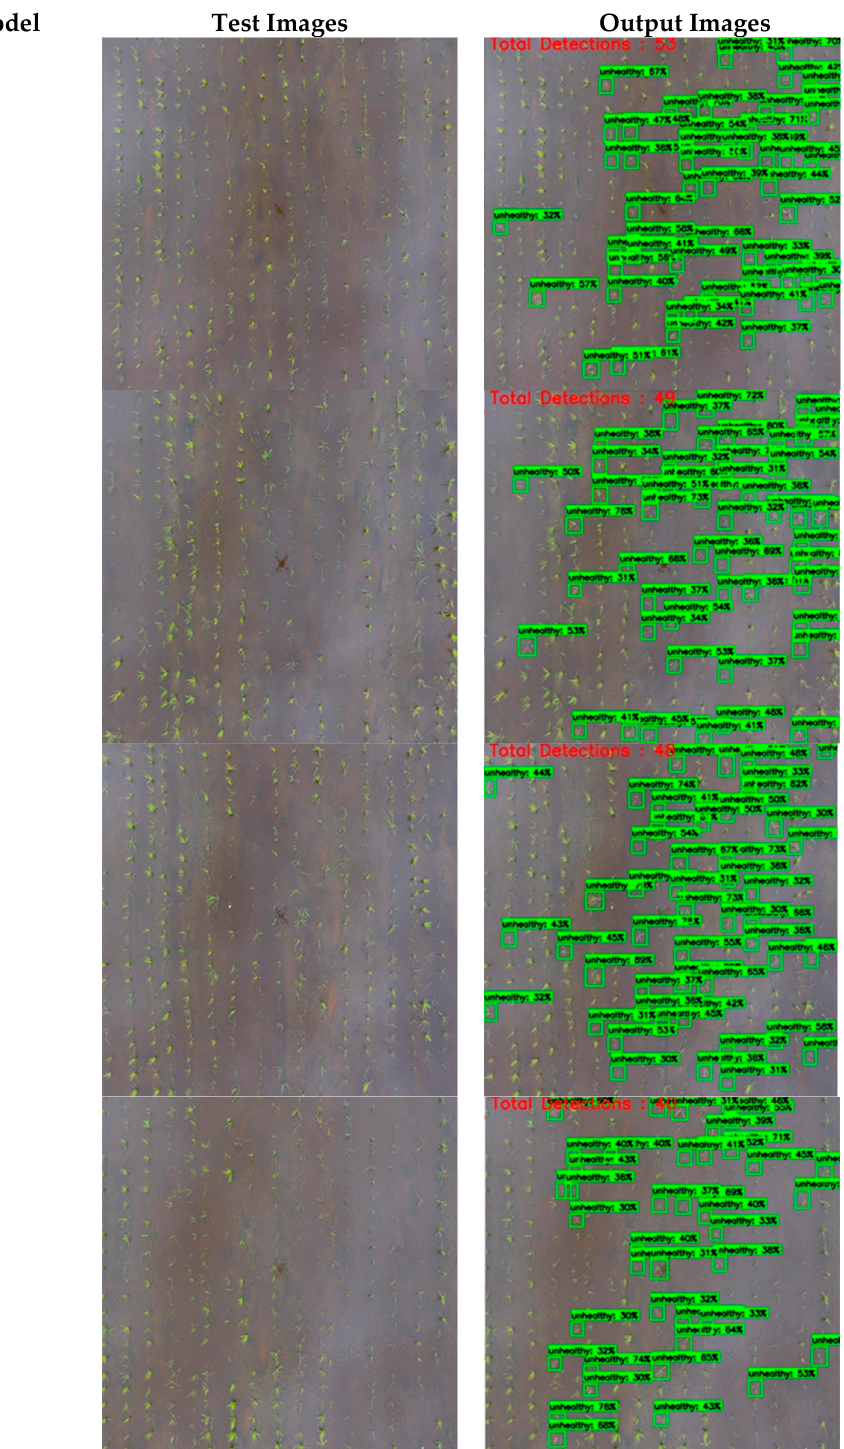
Figure 9. Detection result of defective paddy seedlings using one-stage and two-stage method pretrained object detectors: ( a ) EfficeintDet-D1+EfficientNet; ( b ) Faster R-CNN+ResNet50; ( c ) SSD+MobileNetV2; and ( d ) SSd+ResNet50.